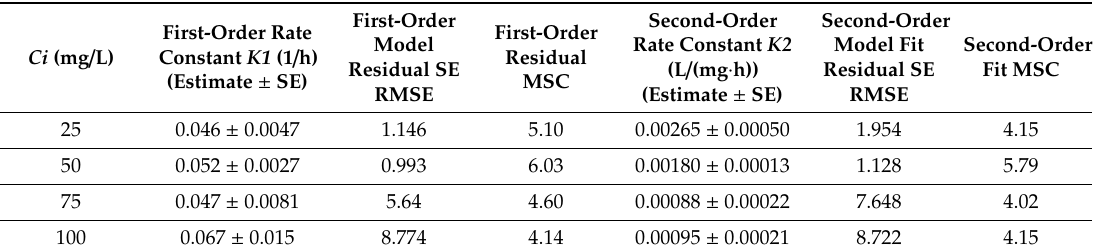
Table 3. Fitted parameters for adsorption vs. time curves at di ff erent initial concentrations (25, 50, 75 and 100 mg / L): first-order model in Equation (7) and a second-order rate equation (Equation (8)) [46]. (SE for square error, RMSE for root-mean square error, MSC for model selection criterion).